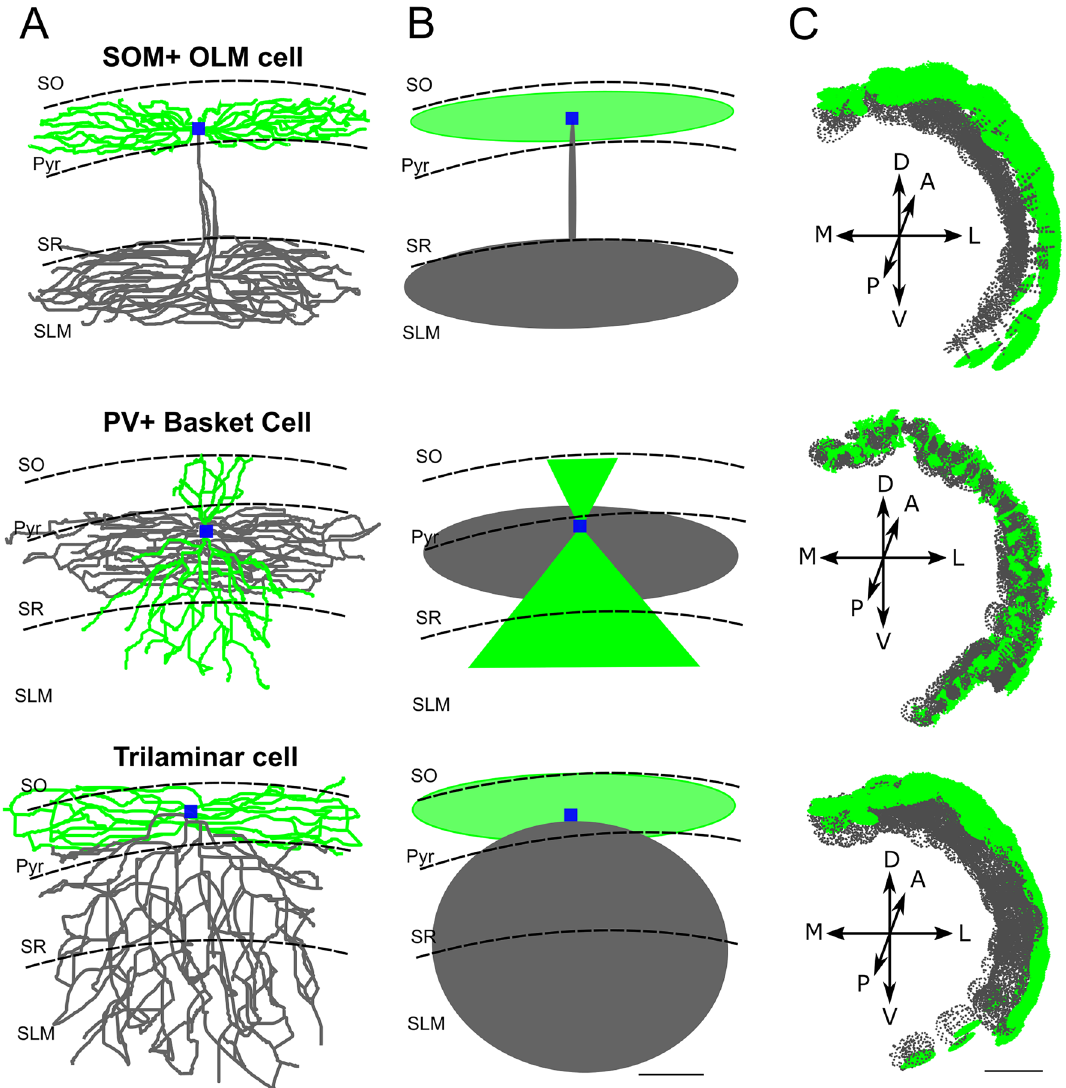
Figure 5. Interneuron morphologies. ( A ) Example of a morphological reconstruction obtained from database neuromorpho.org of three interneurons: Somatostatin positive Oriens interneurons (SOM + OLM); Parvalbumin positive basket cell (PV + Basket cell); Trilaminar cell. Color code is used to represent different morphological compartments (green—dendrites, gray—axons, blue—soma). ( B ) The modelled probability clouds are represented for each of the three neuronal categories with the same color code. ( C ) Probability clouds are positioned in the CA1 respecting the orientation of axons and dendrites with respect to the internal layers and to the external hippocampal subregions (CA3 and subiculum). Scale bar ( A , B 100 µm; C 1000